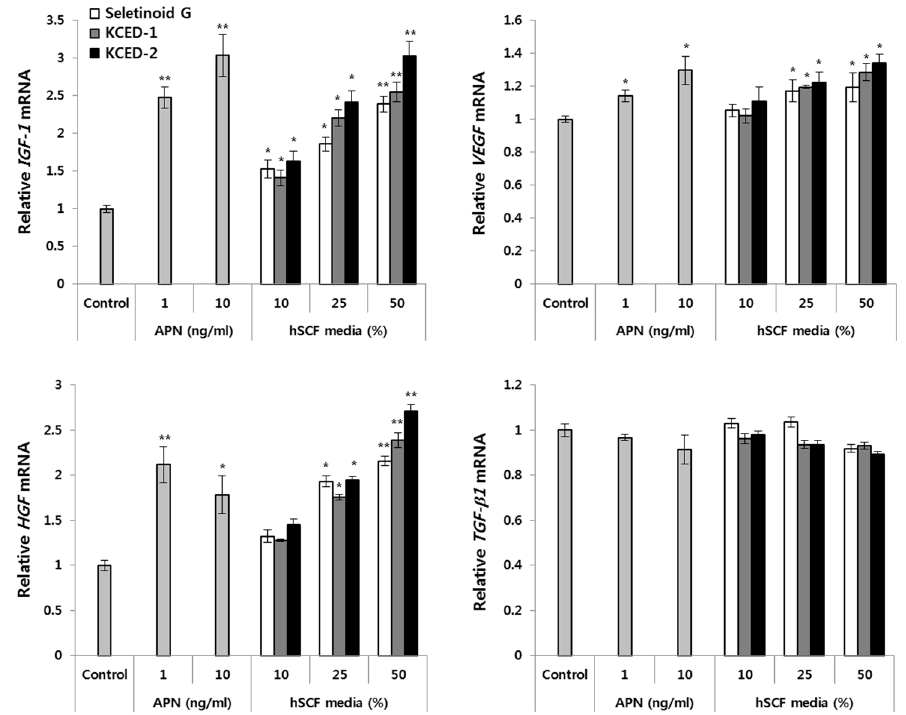
Figure 5. The SG-, KCED-1-, or KCED-2-treated hSCF media increase the mRNA levels of hair growth-related growth factors in hDPCs. The hDPCs were treated with different volumes of 50 μ M SG-, KCED-1-, or KCED-2-treated hSCFs media for 48 h. The mRNA expression of hair growth-related growth factors was analyzed by RT-qPCR using respective Taqman probes. The data are presented as the mean ± SD ( n = 3; * p < 0.05, ** p < 0.01).